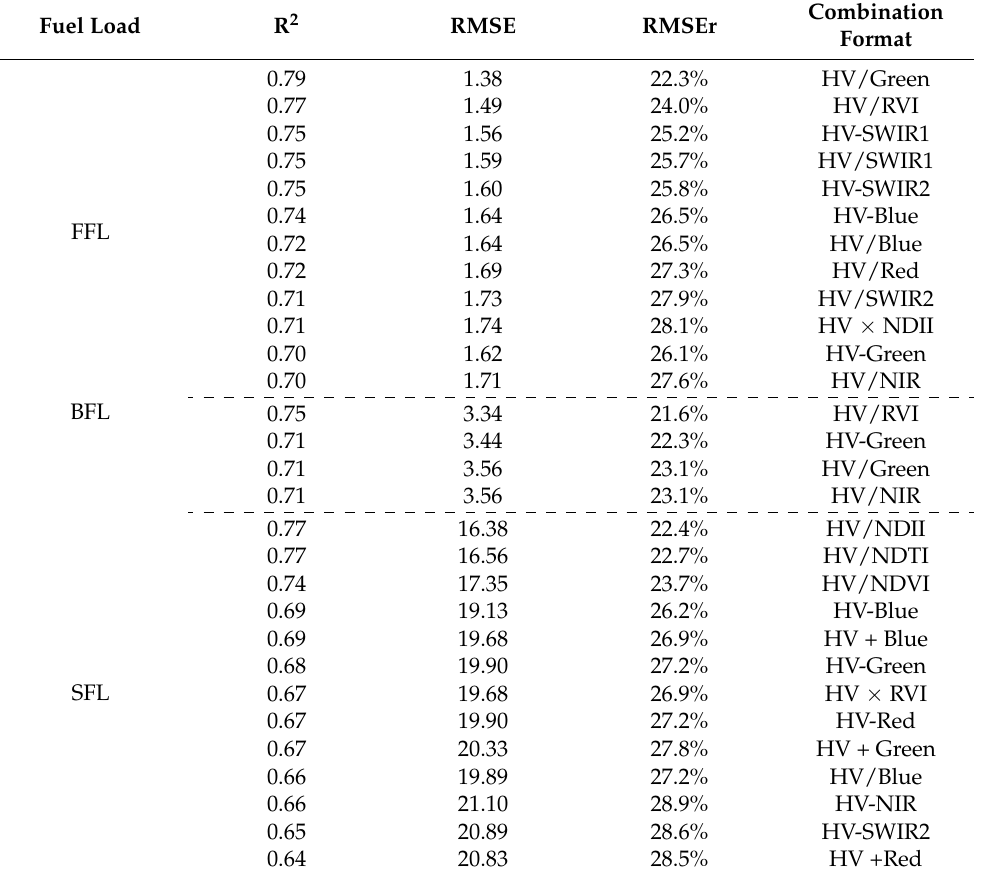
Table 4. Retrieval results of FL AGL (FFL, BFL and SFL) by the combination of HV backscatter and optical information (band or vegetation index) with new model. The bold underlined items are the best retrieval results. Fuel Load R 2 RMSE RMSEr